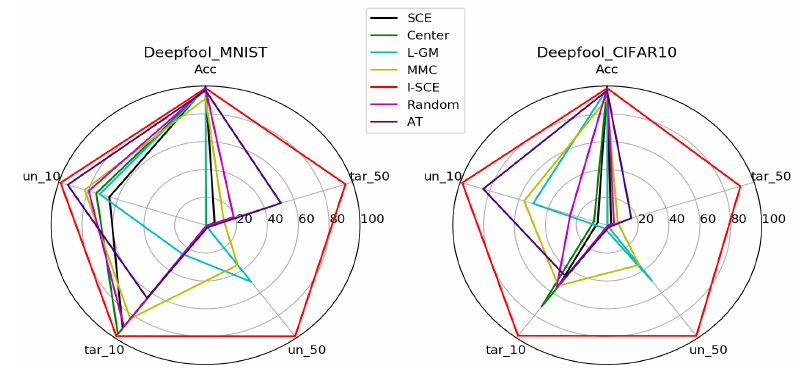
Figure 10. Performance (%) of shallow neural networks under PGD attack on MNIST.